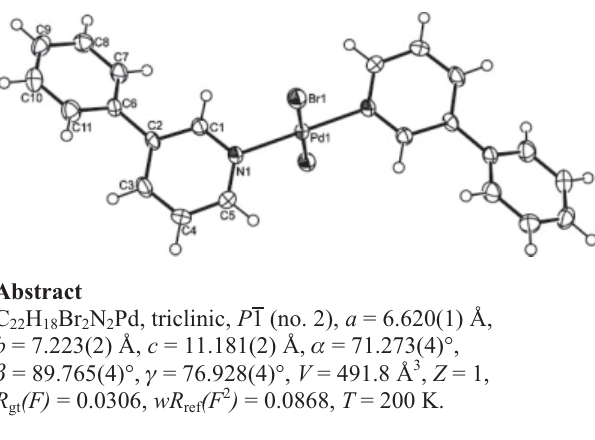
Table 1. Data collection and handling.